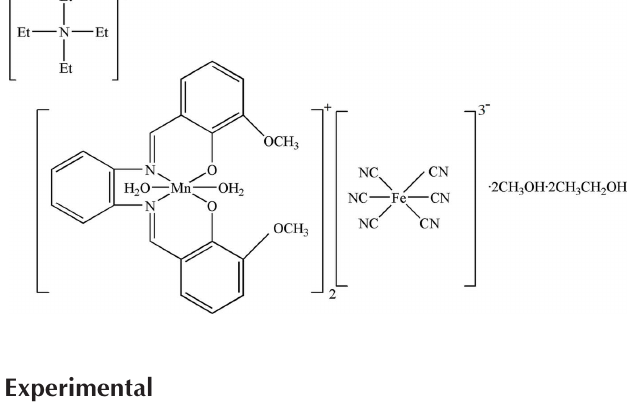
Key indicators: single-crystal X-ray study; T = 296 K; mean (cid:2) (C–C) = 0.005 A˚; disorder in solvent or counterion; R factor = 0.048; wR factor = 0.129; data-to- parameter ratio = 16.7.